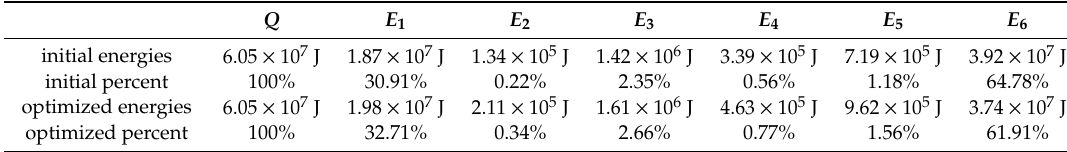
Table 8. Comparison of energies before and after